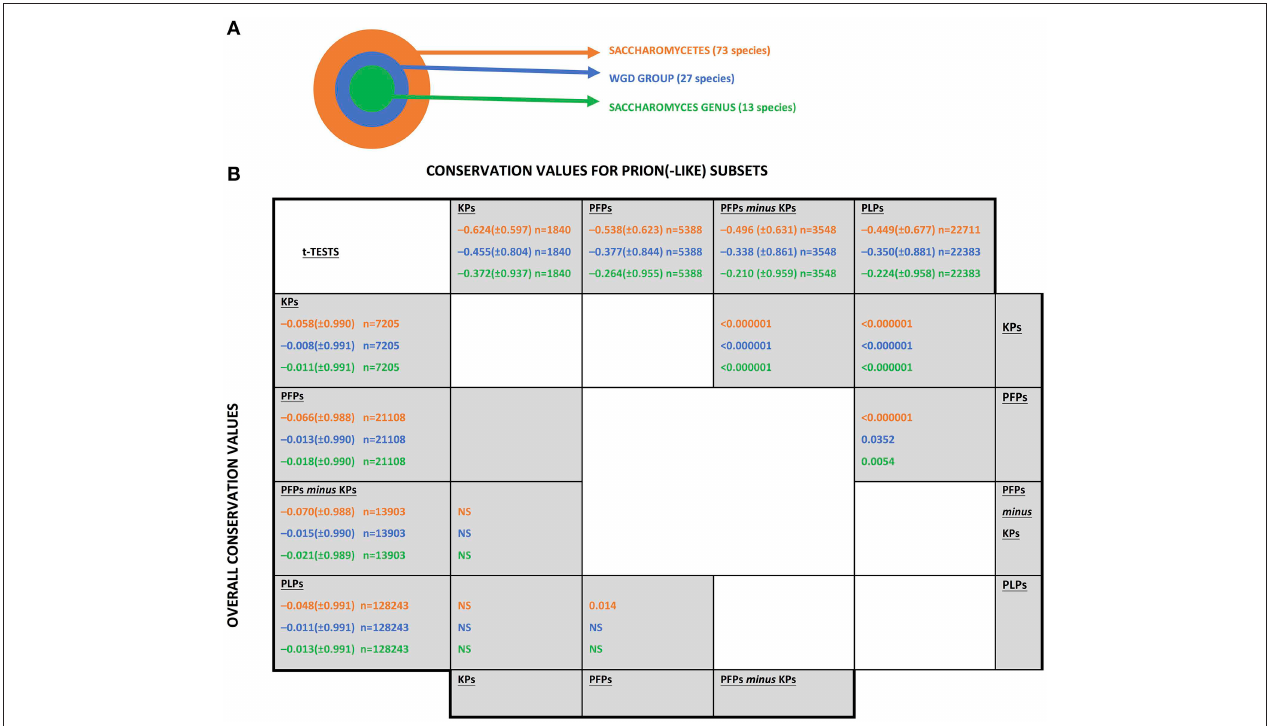
FIGURE 1 | The fungal levels examined for conservation of prion(-like) proteins from Saccharomyces cerevisiae . (A) A schematic of the three taxonomic levels examined. “WGD” stands for “whole genome duplication.” (B) Conservation values of the different sets of prion-like or prion-forming domains. The abbreviations for the sets are as listed in section Methods. The mean conservation values for prion-forming or prion-like domains are listed along the top of the table, with the values for the whole sequences listed along the left-hand column. The standard deviations are in brackets. The number of coulmns in each sample is indicated (n). They are colour-coded as in part (A) . t- Tests were performed to compare the mean conservation values for each set, in the upper diagonal half for the prion(-like) domains and in the lower diagonal for the whole sequences of the same proteins. “NS” means “not